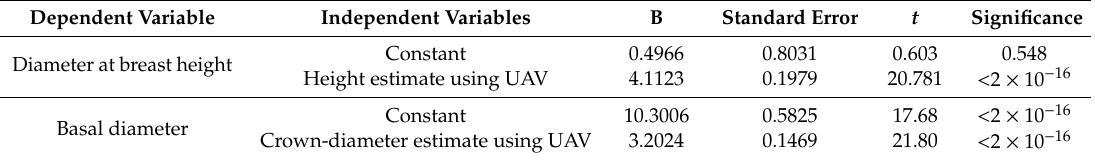
Table 4. Simple regression coe ffi cients predicting basal diameter and diameter at breast